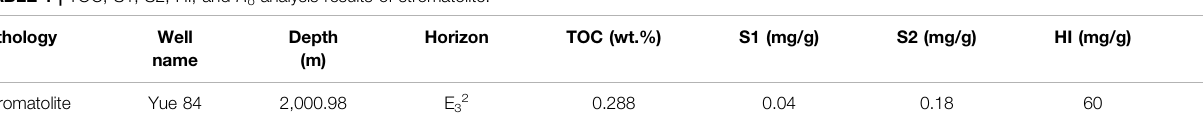
TABLE 1 | TOC, S1, S2, HI, and R o analysis results of